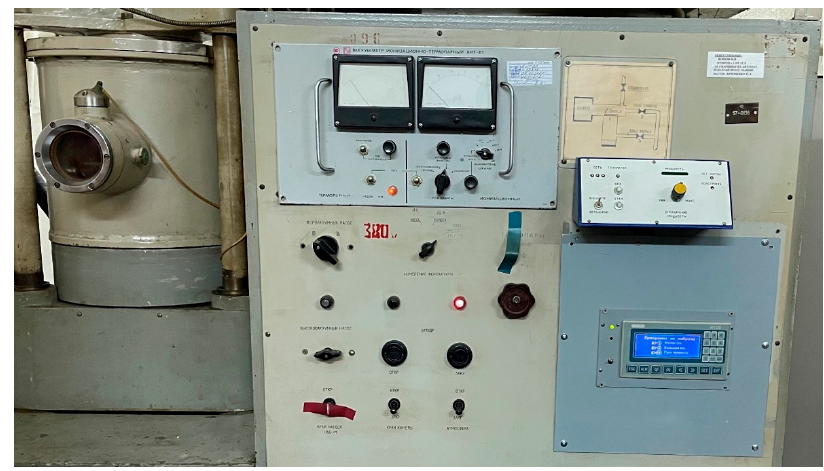
Figure 5. Installation for diffusion welding A306.04.